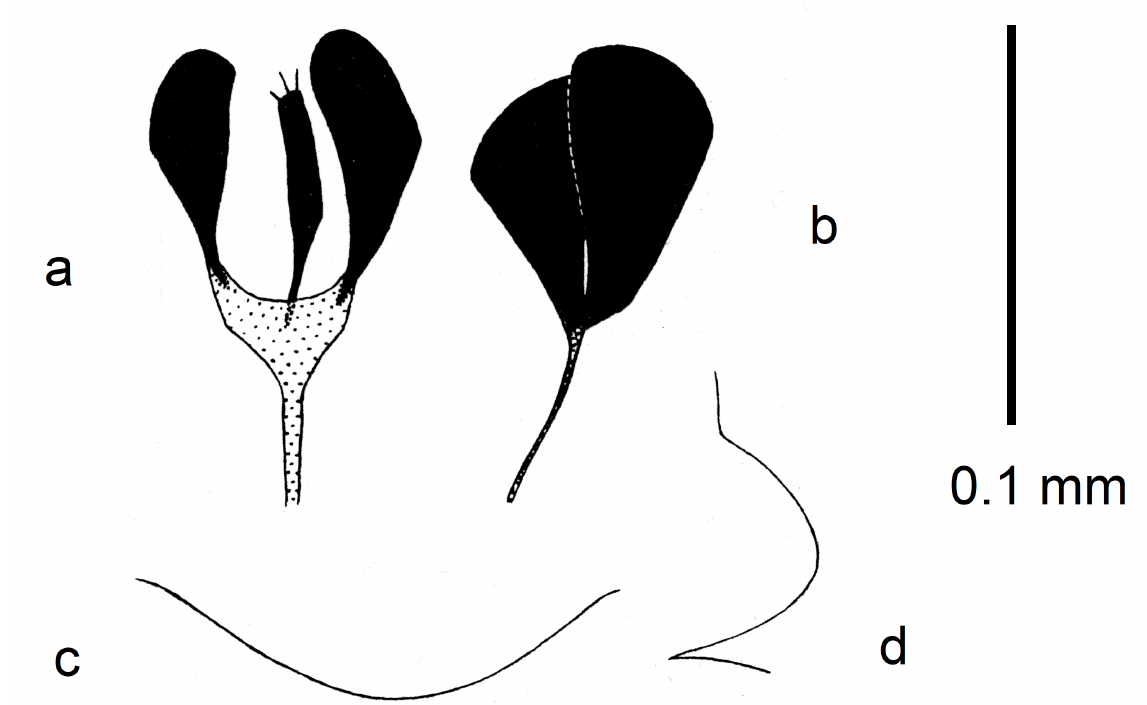
Fig. 2. Atherigona parviclivis Muller, 2015. a . Trifoliate process, ventral. b . Same, lateral. c . Hypopygial prominence, dorsal. d . Same,